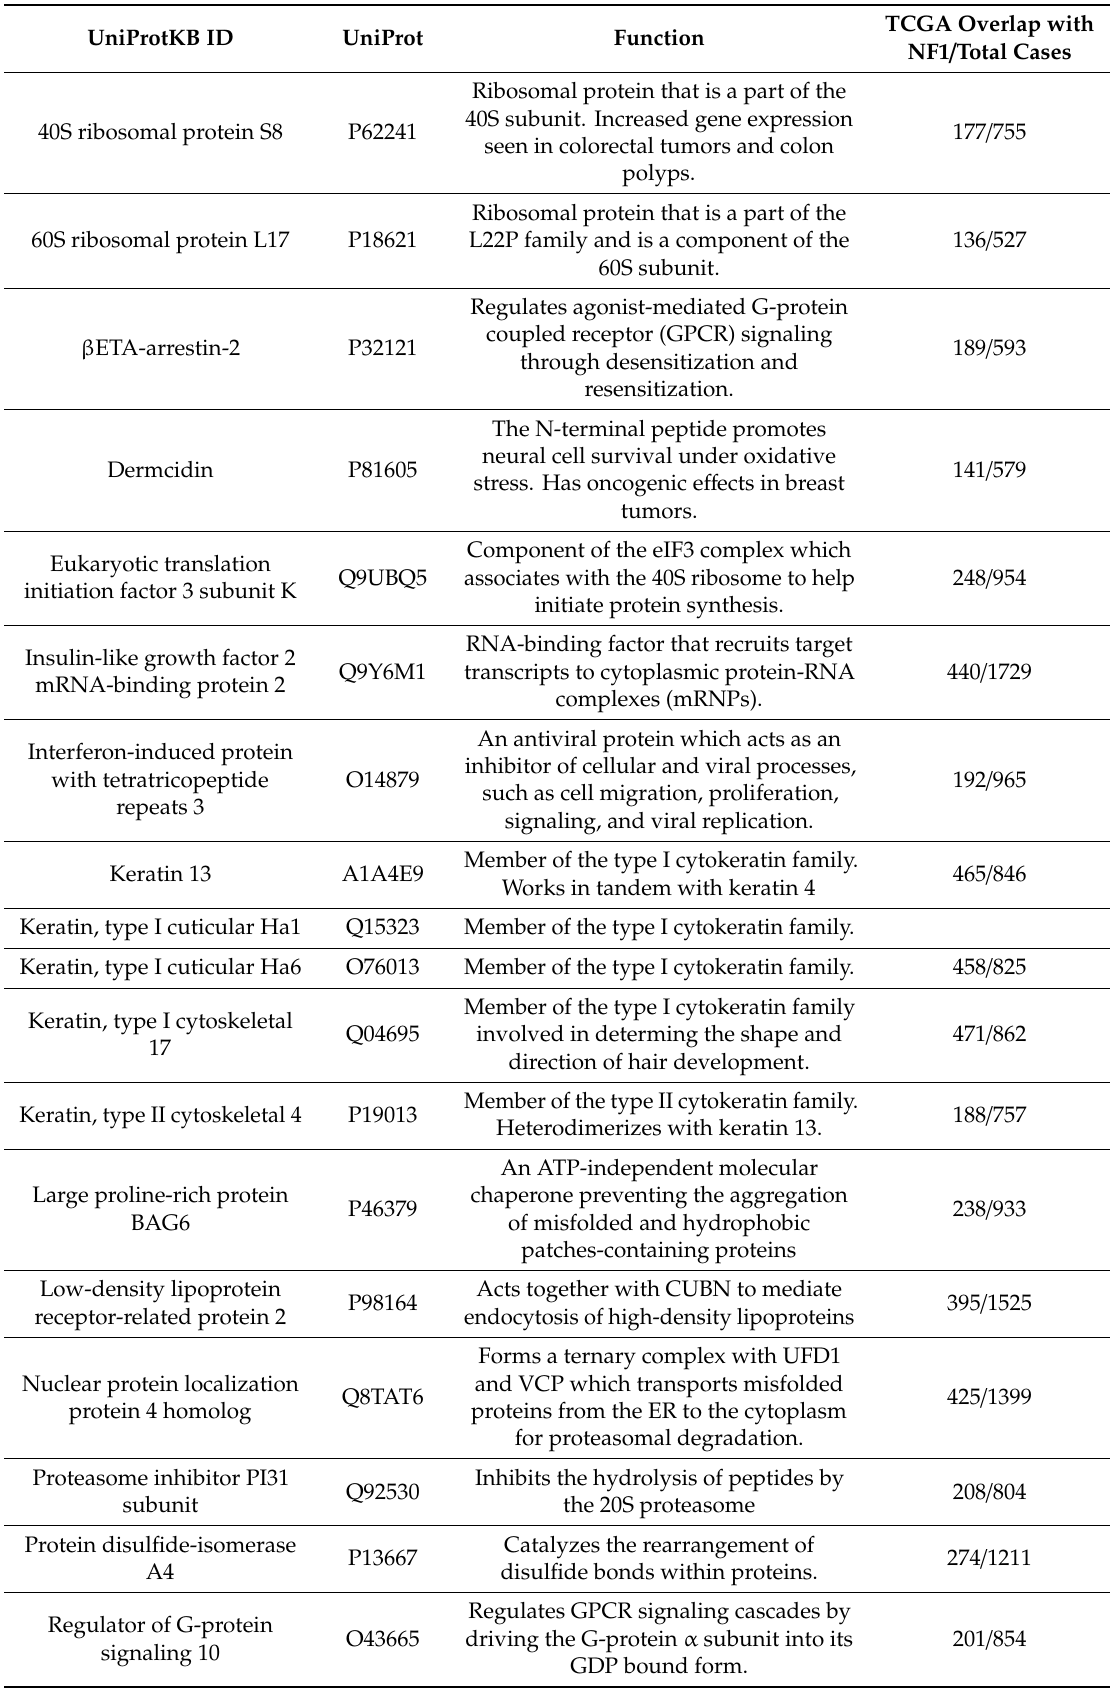
Table 1. High-Confidence NF1 protein–protein interactions